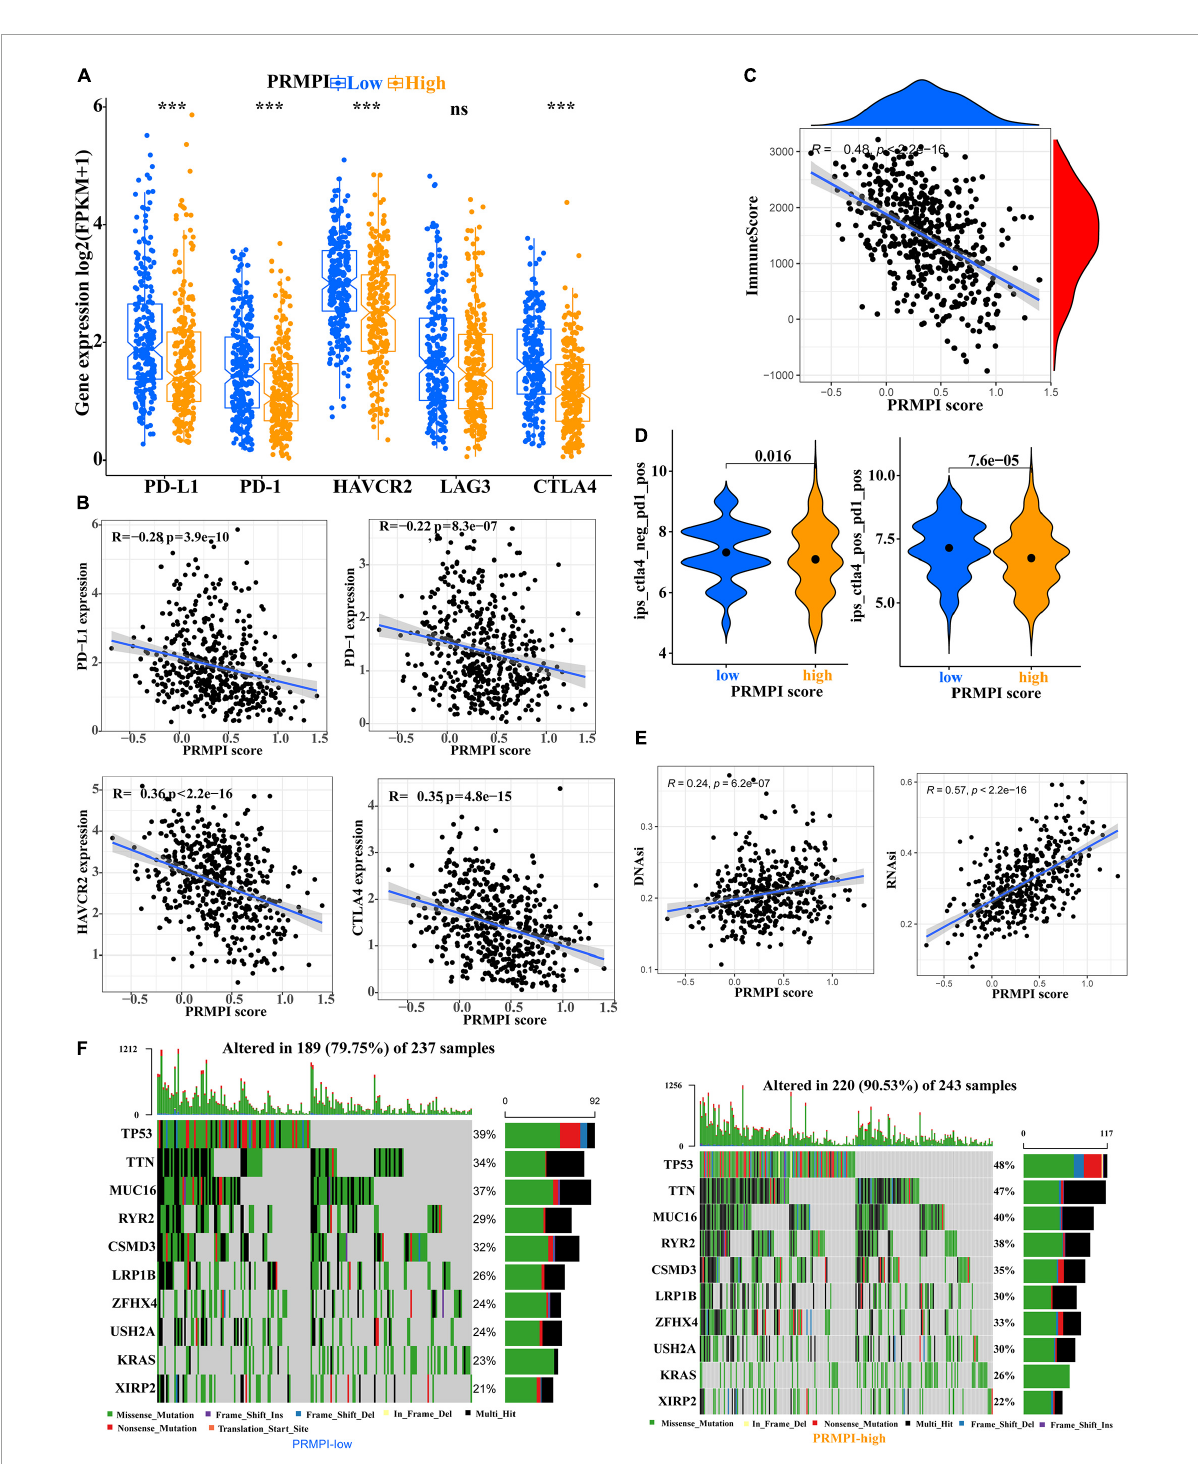
FIGURE7 Levels of immune checkpoint molecule, immune score, relative probabilities to respond to immunotherapy, tumor stemness, and tumor mutation profile in the PRMPI subgroups. (A) Level of immune checkpoint molecules in low-PRMPI and high-PRMPI subgroups. Correlation analysis of the PRMPI score with immune checkpoint molecules (B) and immune scores (C) . (D) Relative probabilities to respond to immunotherapy in the low-PRMPI and high-PRMPI subgroups. (E) Relationship between the PRMPI score and DNAsi and RNAsi. (F) Mutation profile in the mutated LUAC samples from different PRMPI score subgroups. Mutated genes were sorted according to the mutation rate; the samples were arranged to exhibit mutual exclusivity between